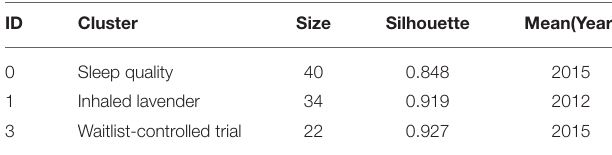
TABLE 5 | Clusters in the reference cooccurrence